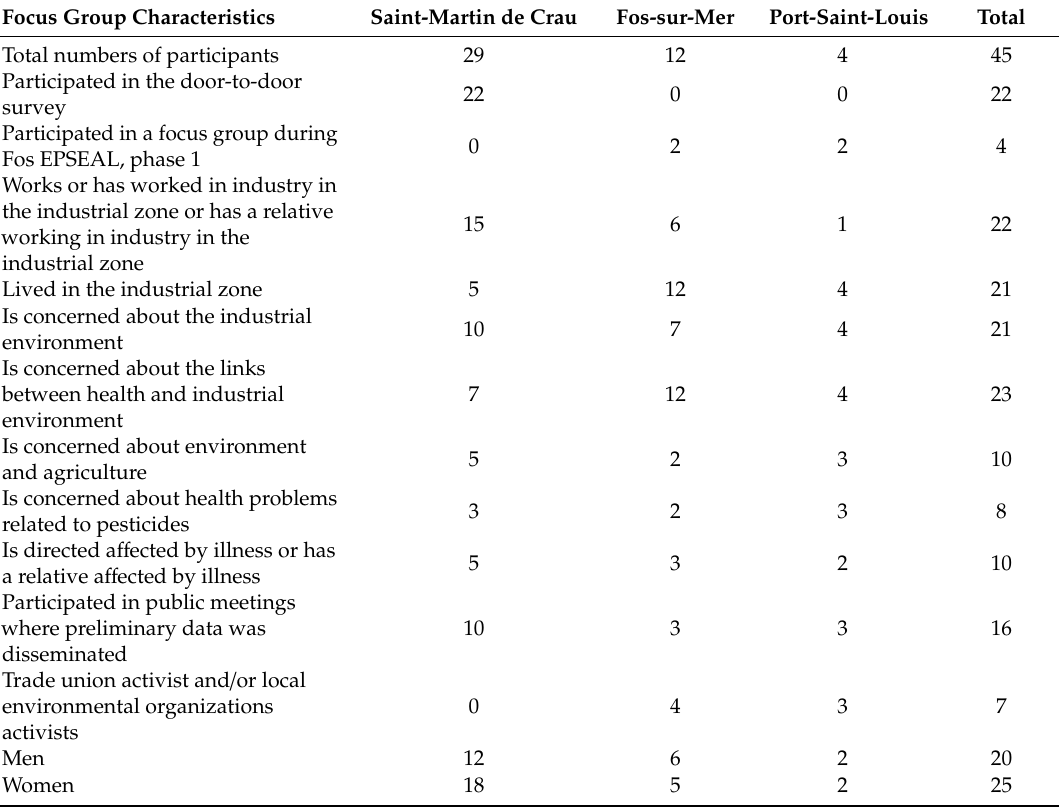
Table 4. Summary profile of focus group participants in Phase 2 of Fos